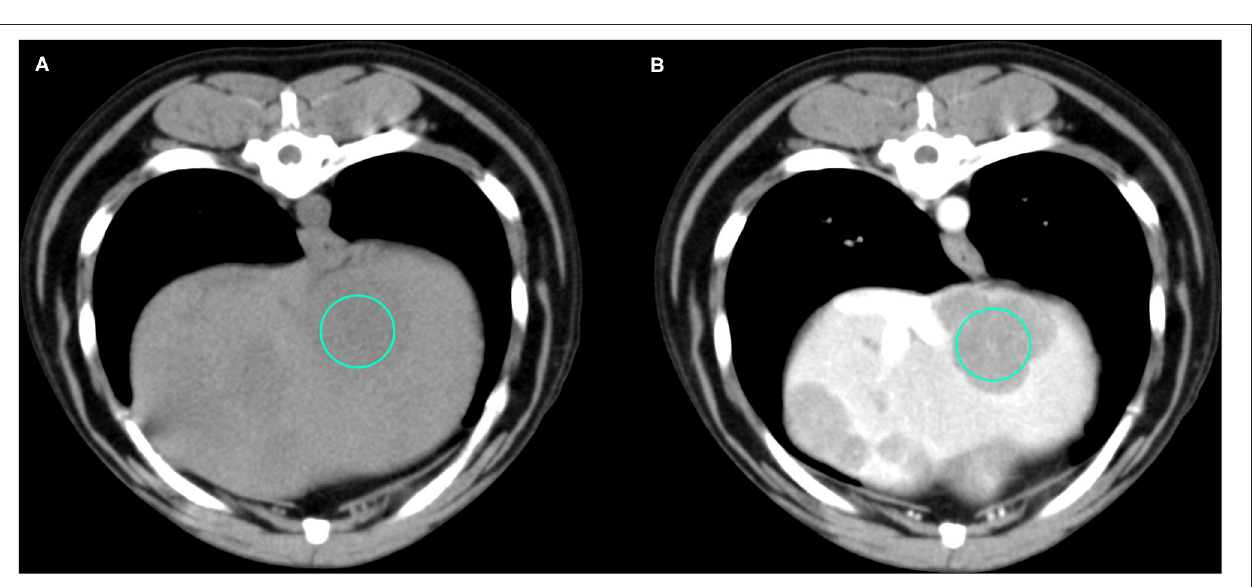
FIGURE 4 | Example of an OML (diagnosed as lymphoma) showing hypoattenuation and hypoenhancement, diffuse contrast enhancement pattern, with heterogeneous distribution, well-defined margins, irregular surface, and solid appearance. (A) image obtained from the pre-contrast scan; (B) image obtained from the delayed scan. A ROI is placed inside the lesion in both. Based on the developed decision tree this lesion was classified as